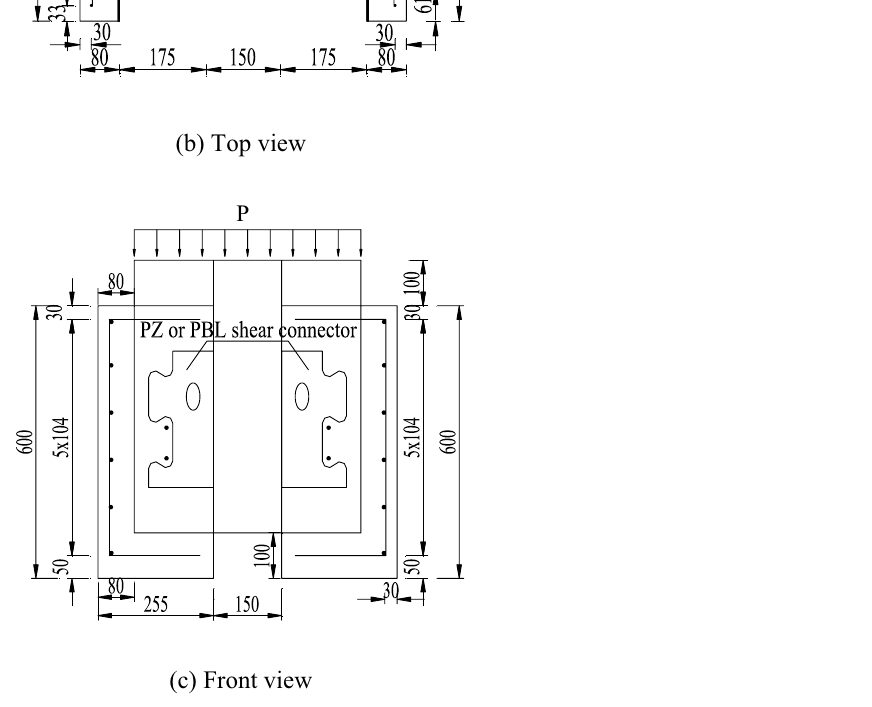
Figure 3. Structural dimensions of push-out